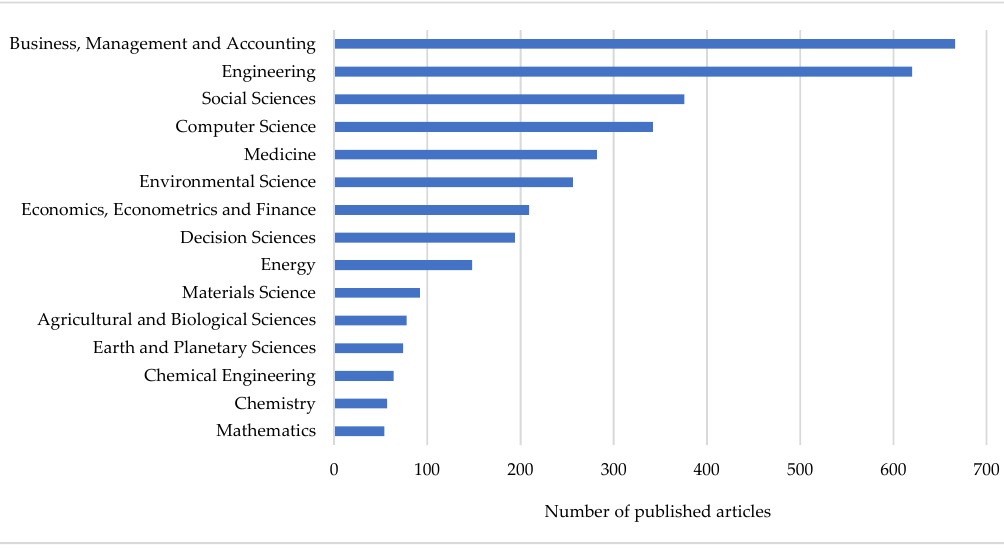
Figure 3. Top 15 thematic areas (1975–2019).